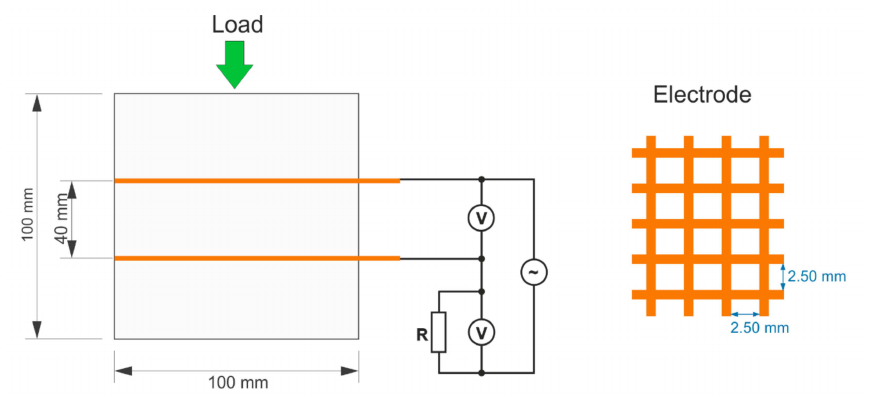
Figure 2. Experimental setup for the measurement of self-sensing properties under